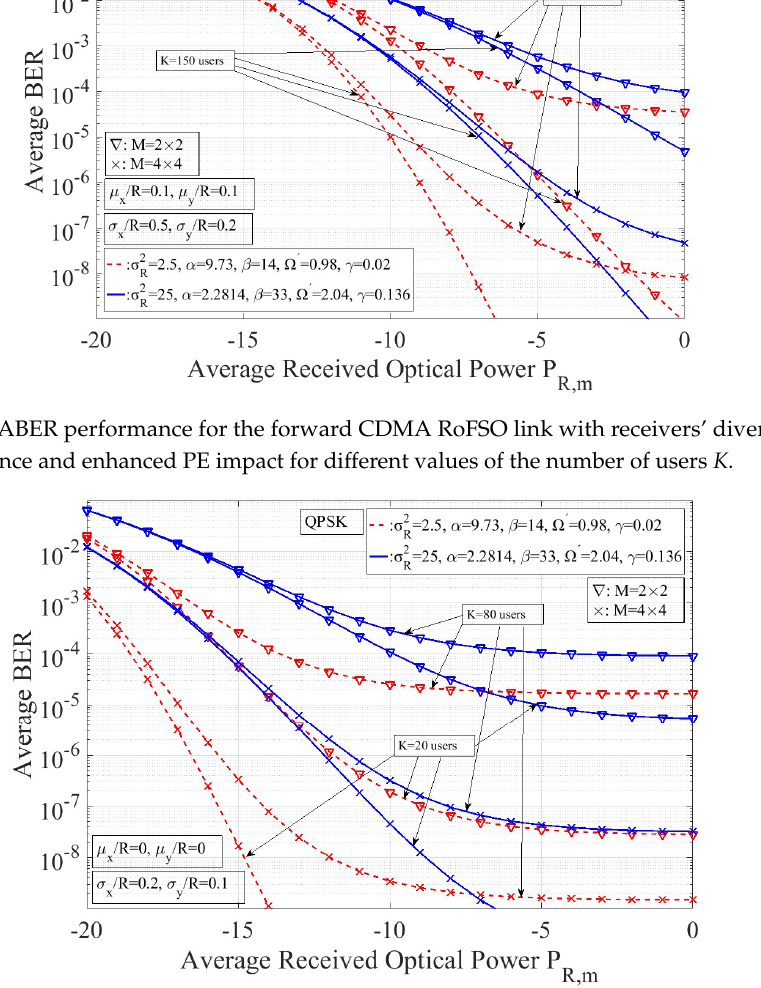
Figure 5. The ABER performance for the reverse CDMA RoFSO link with receivers’ diversity, over strong turbulence and weak PE impact for different values of the number of users K .